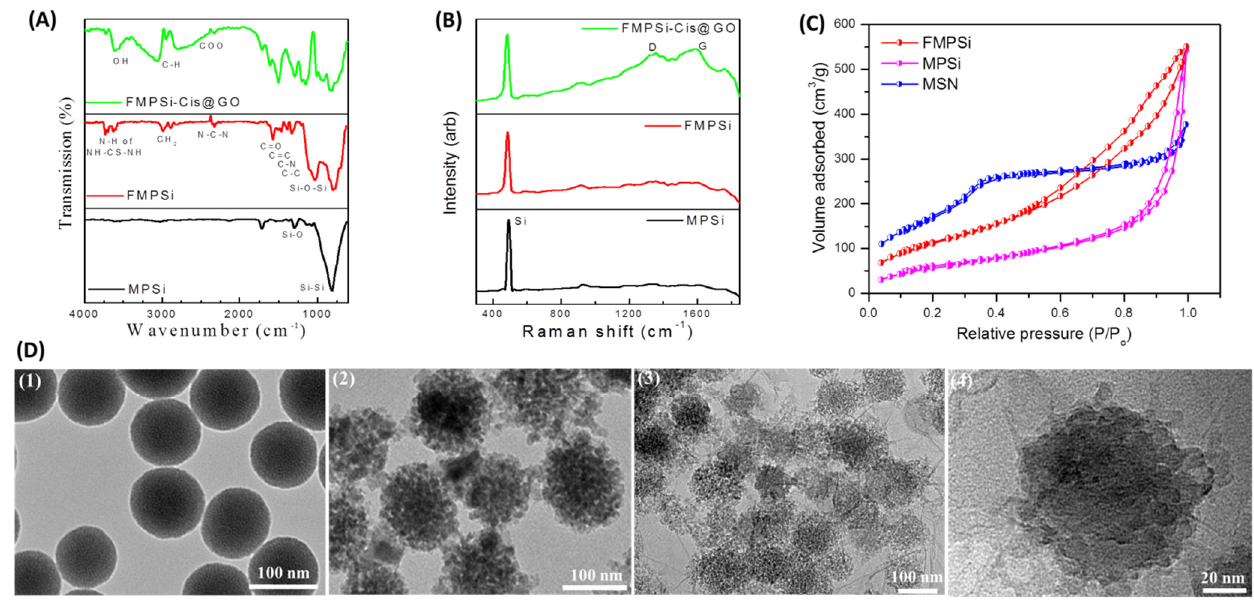
Figure 1. ( A ) FT-IR spectra of MPSi, FMPSi, and FMPSi-Cis@GO; ( B ) Raman spectra of MPSi, FMPSi, and FMPSi-Cis@GO; ( C ) Nitrogen adsorption/desorption isotherms and pore size distribution using the Barrett–Joyner–Halenda (BJH) analysis of as-prepared samples (MSN, MPSi, and FMPSi); and ( D ) TEM images: ( 1 ) MSN, ( 2 ) FMPSi, ( 3 ) FMPSi@GO, and ( 4 ) FMPSi-Cis@GO@DQA.